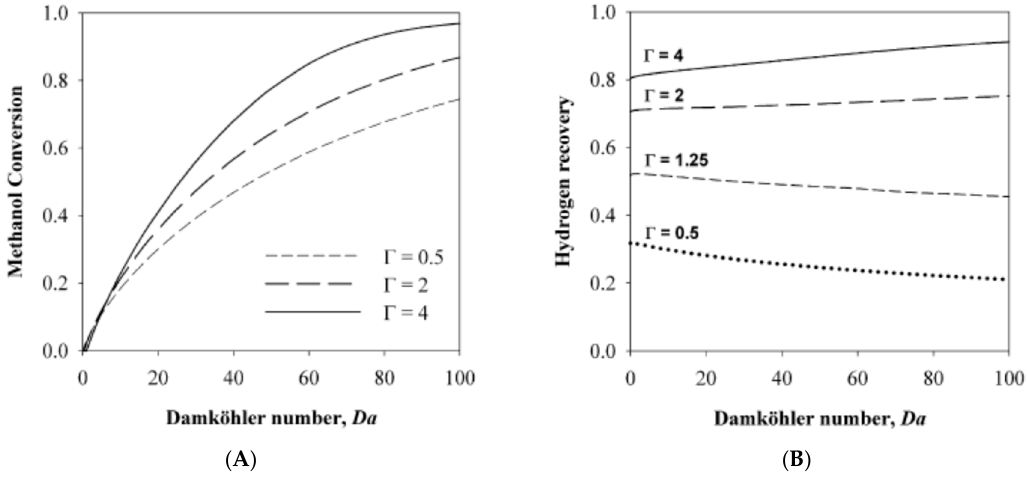
Figure 12. Simulation results of MSR reaction carried out in a MR followed by a PROX reactor: Methanol conversion ( A ) and hydrogen recovery ( B ) vs. Damköhler number at various contact time; With permission of reprint of Elsevier from Sà et al. [14].